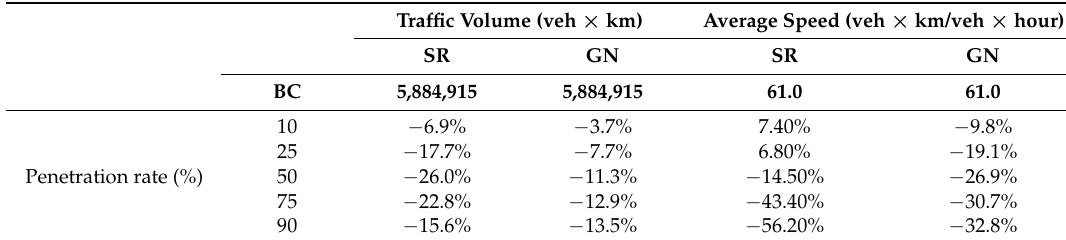
Table 3. Changes in traffic volumes and averages speeds between the SR and the GN highly-congested scenarios.